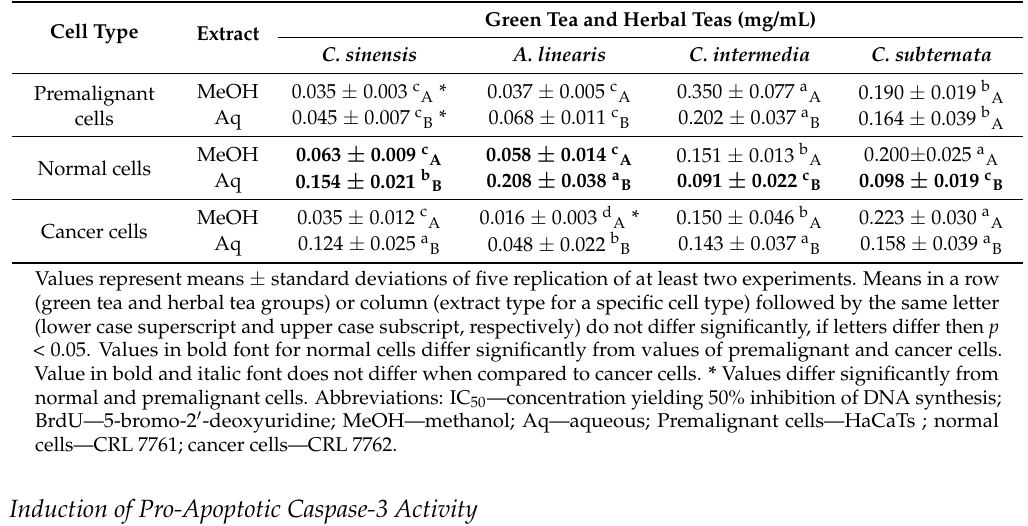
Table 1. Anti-proliferative activity (BrdU IC 50 ) of aqueous and methanol extracts of green tea and different herbal teas in skin cells. Green Tea and Herbal Teas Extract